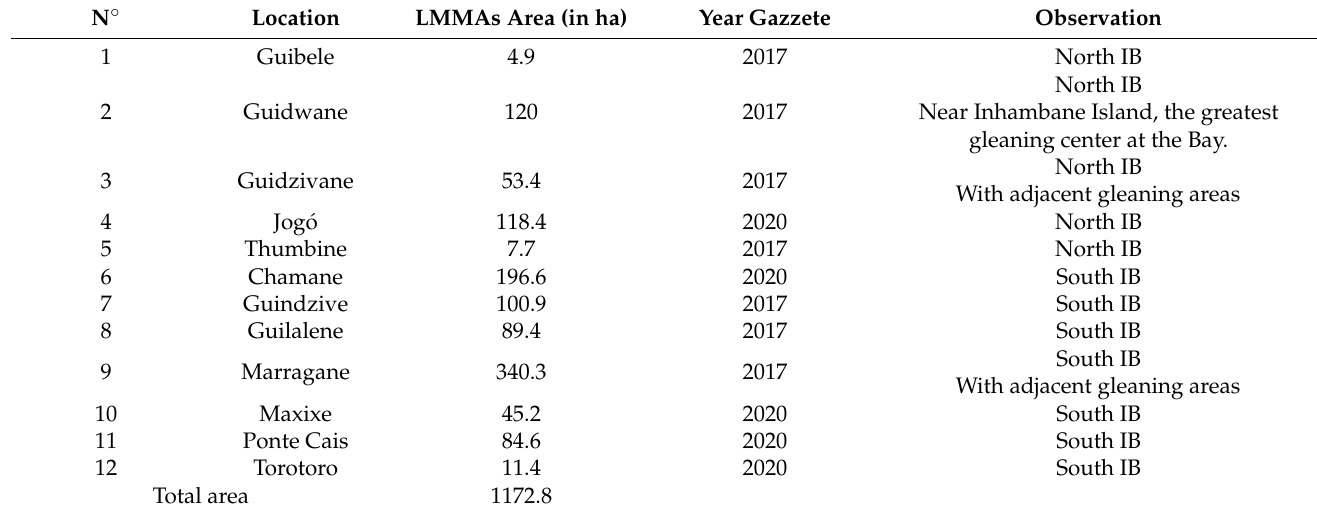
Table 8. Details on the 12 MPAs created in Inhambane